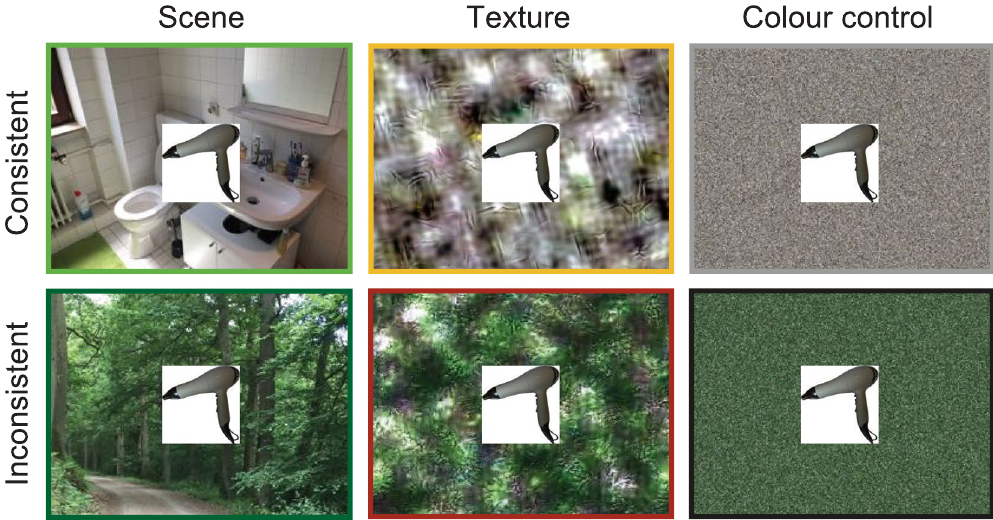
Figure 2. Examples of consistent and inconsistent real-world scenes, textures, and colour